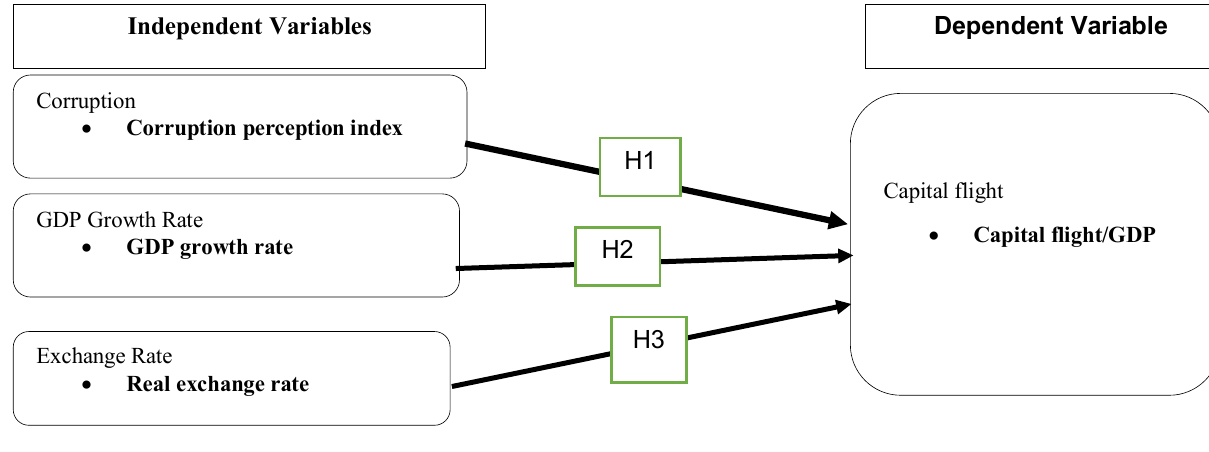
Figure 1: Conceptual